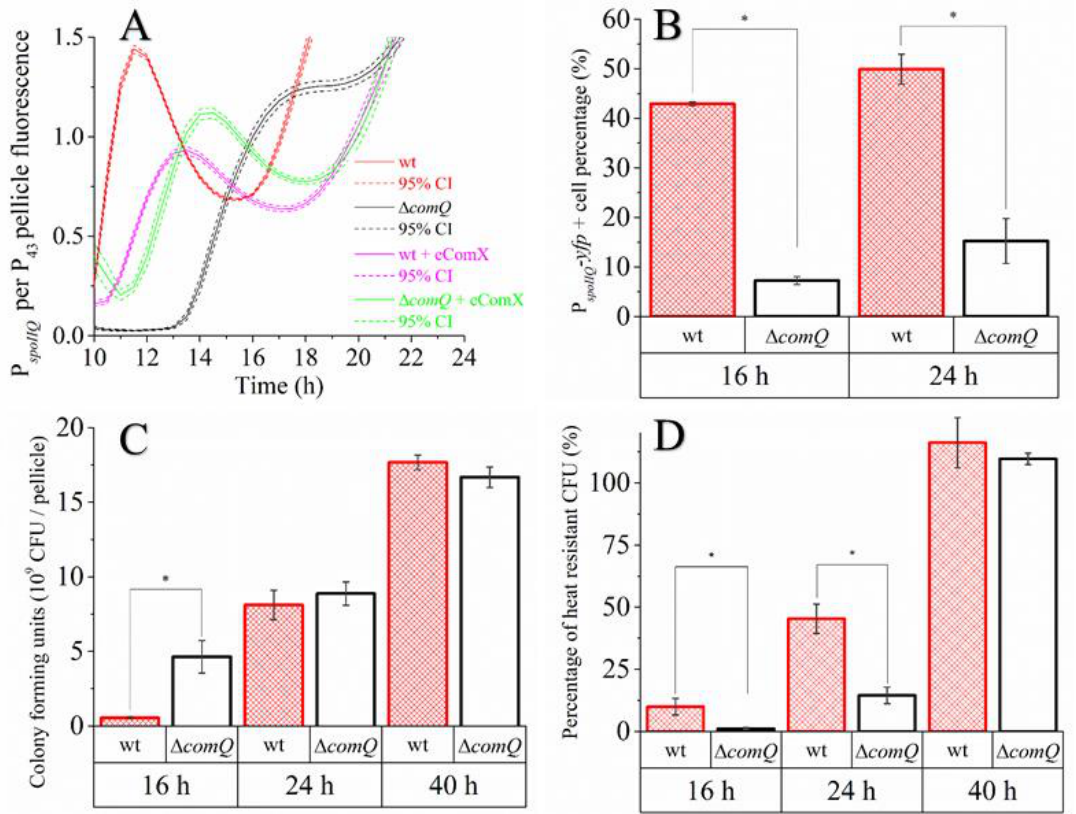
Figure 7. Comparisons of B. subtilis PS-216 wild type (wt) and QS mutant ( Δ comQ ) during static growth in MSgg medium at 37 °C. ( A ) Pellicle biofilm P spoIIQ -yfp fluorescence normalized per P 43 -